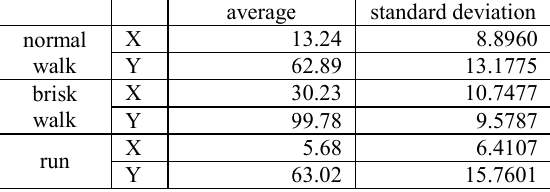
Table 3. Detecting position from X and Y